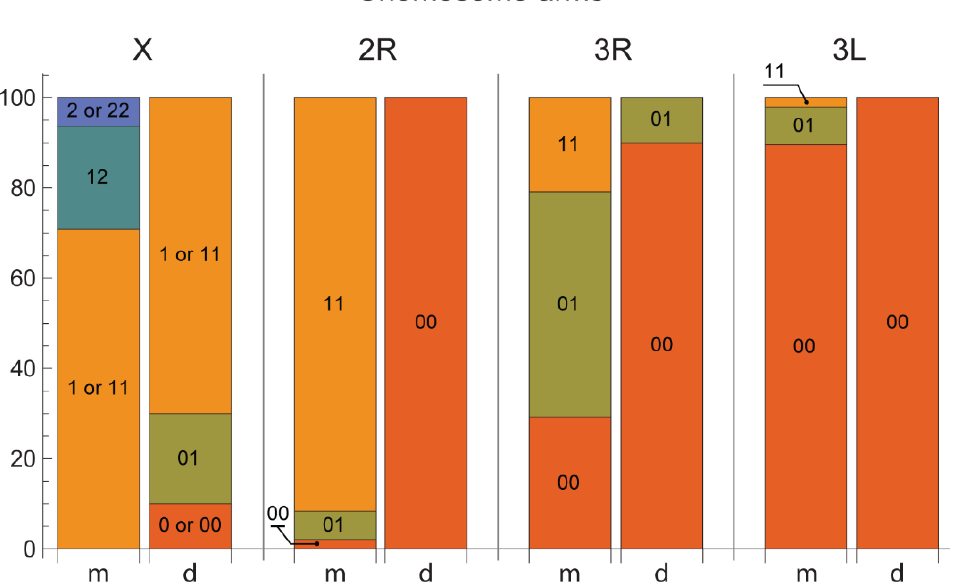
Figure 4. Frequencies of the chromosomal inversions in natural populations of malaria mosquitoes Anopheles daciae and Anopheles messeae in Teguldet, Western Siberia, Russia. The letters “m” and “d” stand for An. messeae and An. daciae , respectively. Frequencies of the standard and inverted variants are shown by different colors in chromosome X, and chromosome arms 2R, 3R, and 3L. Homozygous karyotypes are shown as 00, 11, and 22 and heterozygous karyotypes are shown as 01, 02, and 12. Hemizygous karyotypes in males that have only one chromosome X are indicated as 0, 1, or 2.